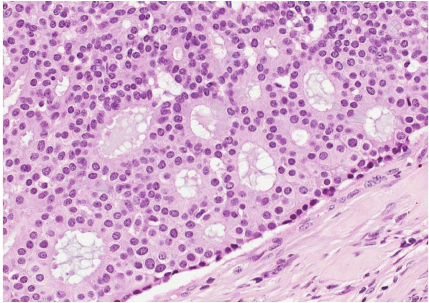
Figure 1: Low-grade DCIS. The neoplastic cells show small uniform nuclei with fine chromatin and are polarized around secondary lumina.